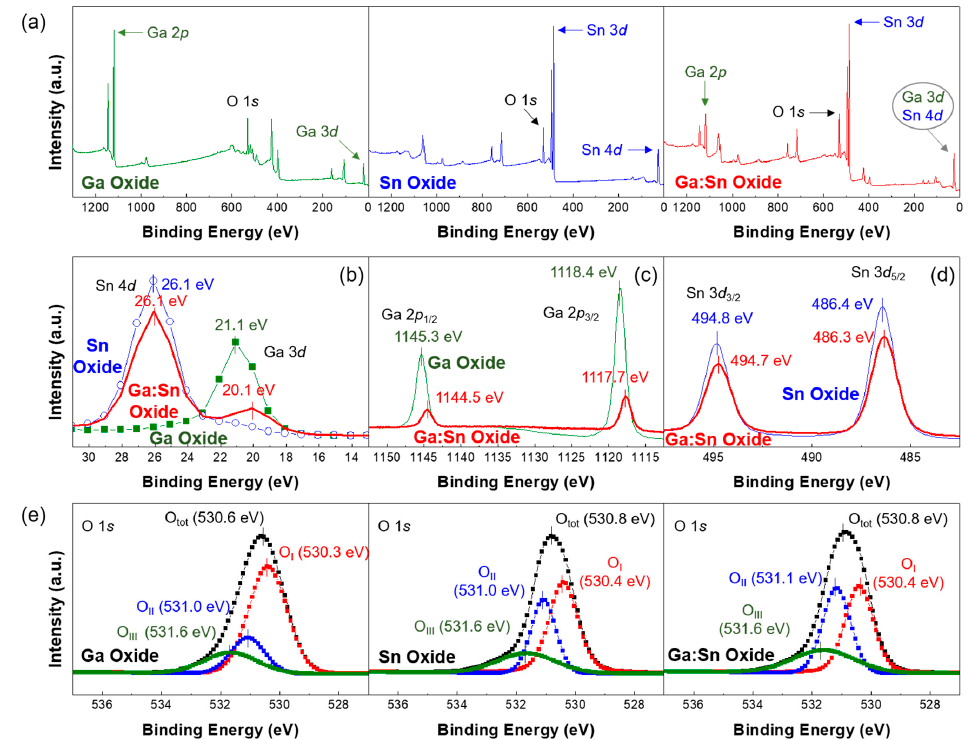
Figure 2. ( a ) XPS (X-ray photoemission spectroscopy) survey peaks of solution-processed Ga oxide, Sn oxide, and Ga:Sn oxide films. High-resolution XPS spectra of ( b ) Ga 3 d and Sn 4 d orbitals, ( c ) Ga 2 p orbitals, and ( d ) Sn 3 d orbitals. ( e ) O 1 s XPS spectra in the Ga oxide, Sn oxide, and Ga:Sn oxide films.